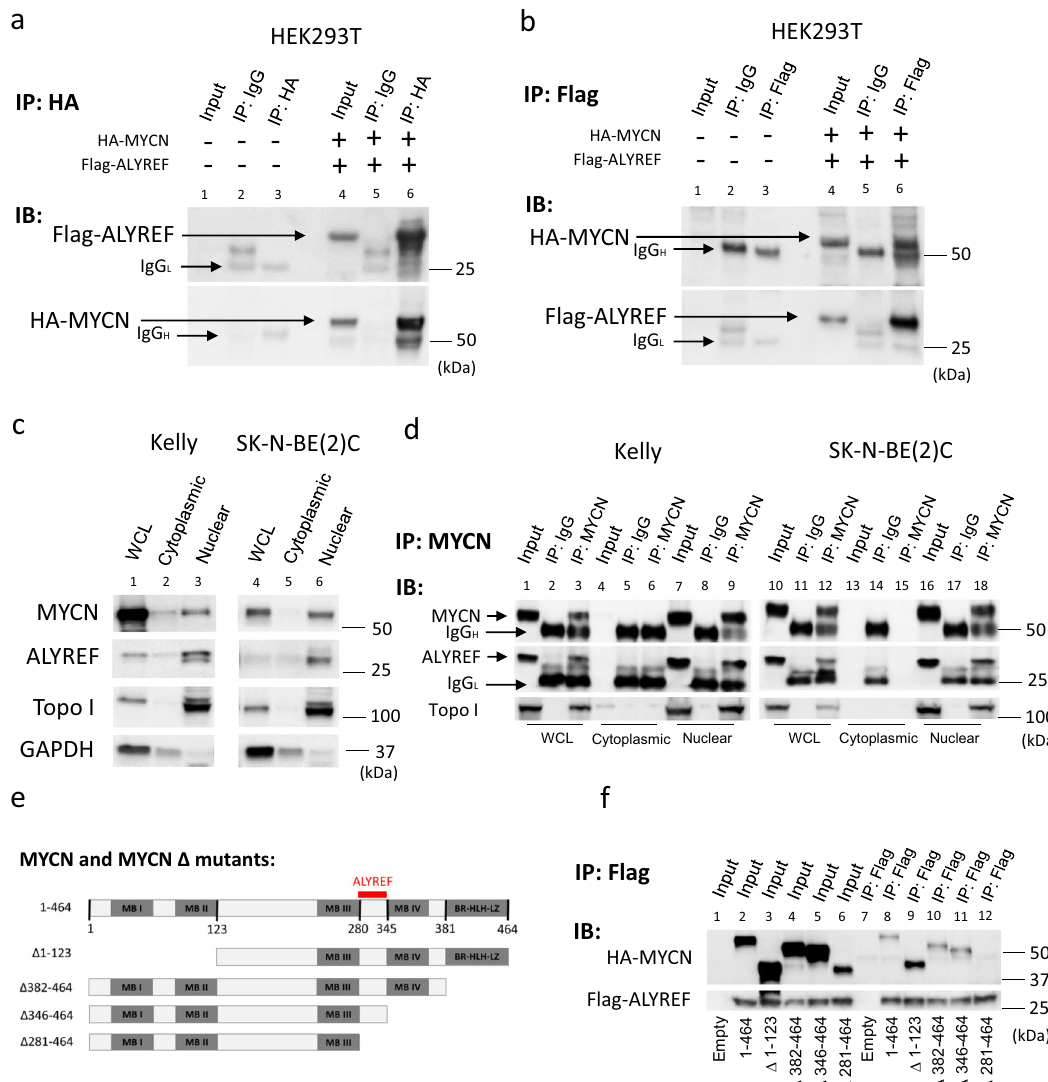
Fig. 4 ALYREF forms a protein complex with MYCN in the nucleus. Representative western blot analysis for the indicated ectopically overexpressed HA- MYCN and Flag-ALYREF from HEK293T cells after immunoprecipitation of a HA-MYCN or b Flag-ALYREF. 5% of the cell lysate was loaded for input. “ - ” indicates HEK293T cells that were transfected with empty vectors. c Representative Western blot analysis for endogenous ALYREF and MYCN localization in Kelly and SK-N-BE(2)C cells following nuclear and cytoplasmic fractionation. WCL whole-cell lysate; Topo I, Topoisomerase I. Topoisomerase I, and GAPDH were used as nuclear and cytoplasmic fraction markers. d Representative Western blot analysis for endogenous ALYREF after immunoprecipitation of endogenous MYCN from Kelly and SK-N-BE(2)C cells following nuclear and cytoplasmic fractionation. 5% of the cell lysate was loaded for input. WCL, whole-cell lysate. Topo I, Topoisomerase I. Topoisomerase I was used as a nuclear marker. e Schematic representation of the HA- MYCN deletion mutants. MB I, MYC box I; MB II, MYC box II; MB III, MYC box III; MB IV, MYC box IV; BR, basic region; HLH, helix-loop-helix; LZ, leucine zipper. f Representative Western blot analysis for the indicated ectopically overexpressed HA-MYCN deletion mutants and Flag-ALYREF from HEK293T cells after immunoprecipitation of Flag-ALYREF. 5% of the cell lysate was loaded for input. Empty indicates HEK293T cells that were transfected with an empty vector. Data are representative of three independent experiments with similar results in a – f